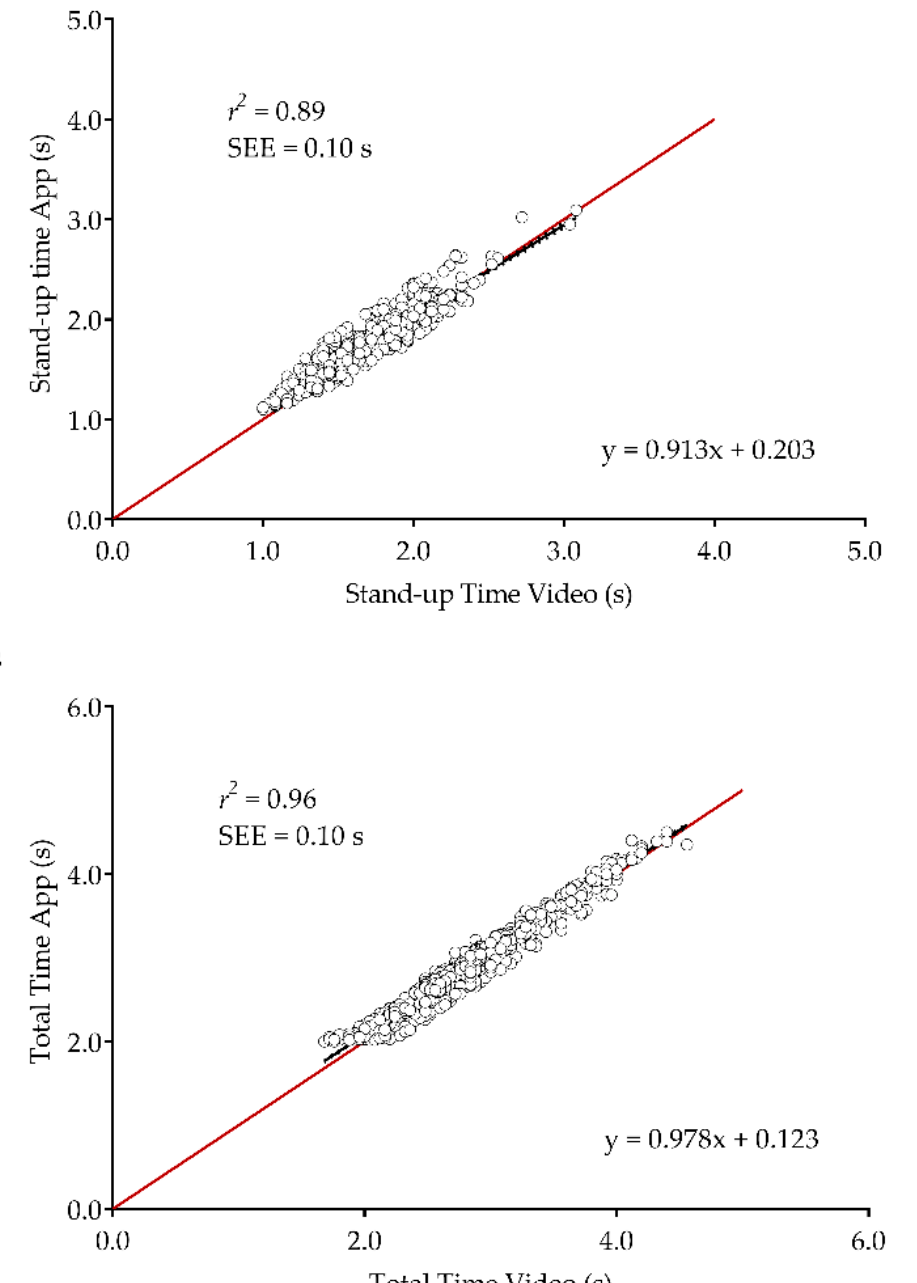
Table 3. Absolute reliability and accuracy inter-devices.